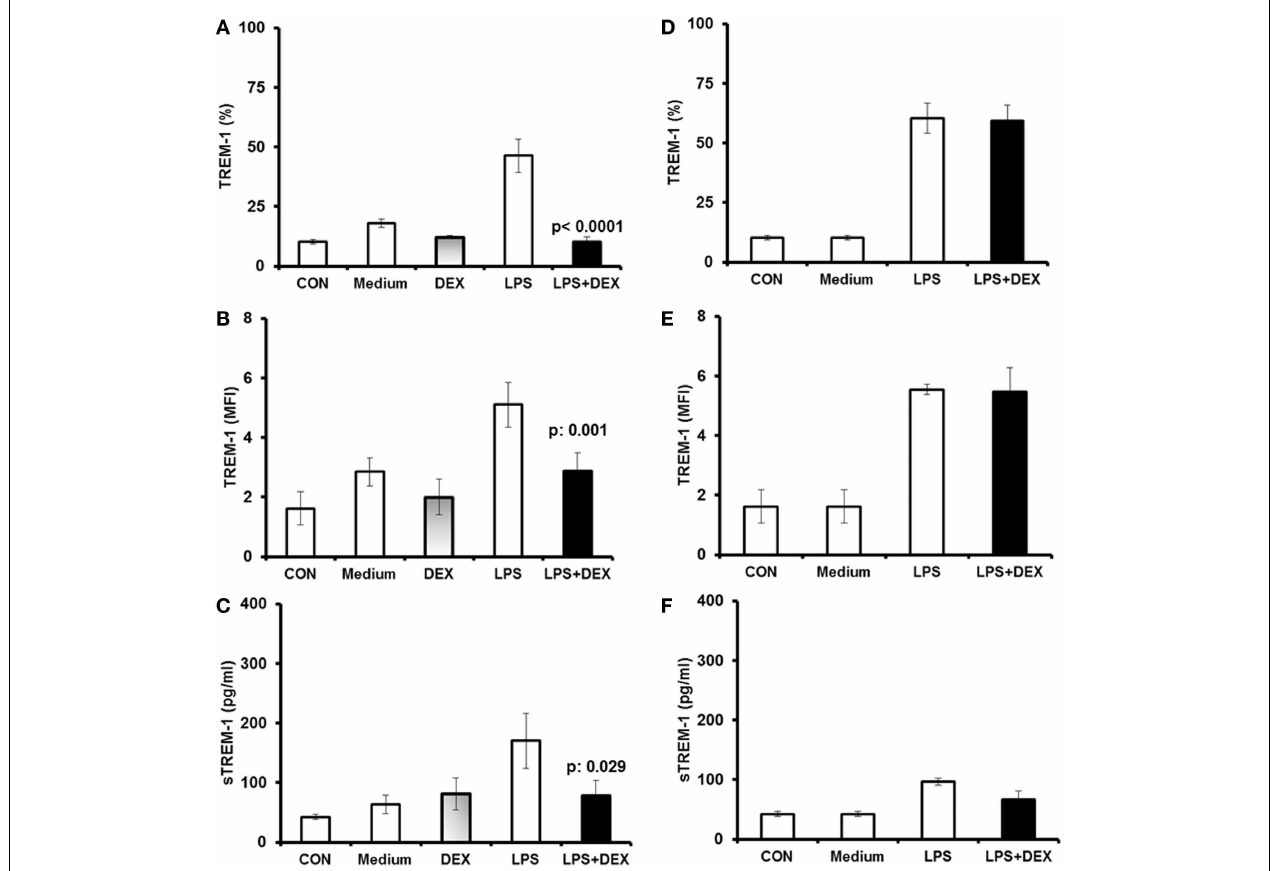
the presence ofTNF α . (D,E) ShowTREM-1 expression after stimulation with LPS in the presence of anti-TNF α , and (F) shows modulation of sTREM-1 production after stimulation with LPS in the presence of anti-TNF α . CON in (A–C) represents unstimulated cells treated in medium alone; CON in (D–F) represent unstimulated cells treated in medium alone. Results from six experiments are shown. Data forTREM-1 are shown as percent of U937 cells expressingTREM-1 (A,D) , or asTREM-1 MFI for U937 cells (B,E) . P values indicate significant differences compared to LPS-treated